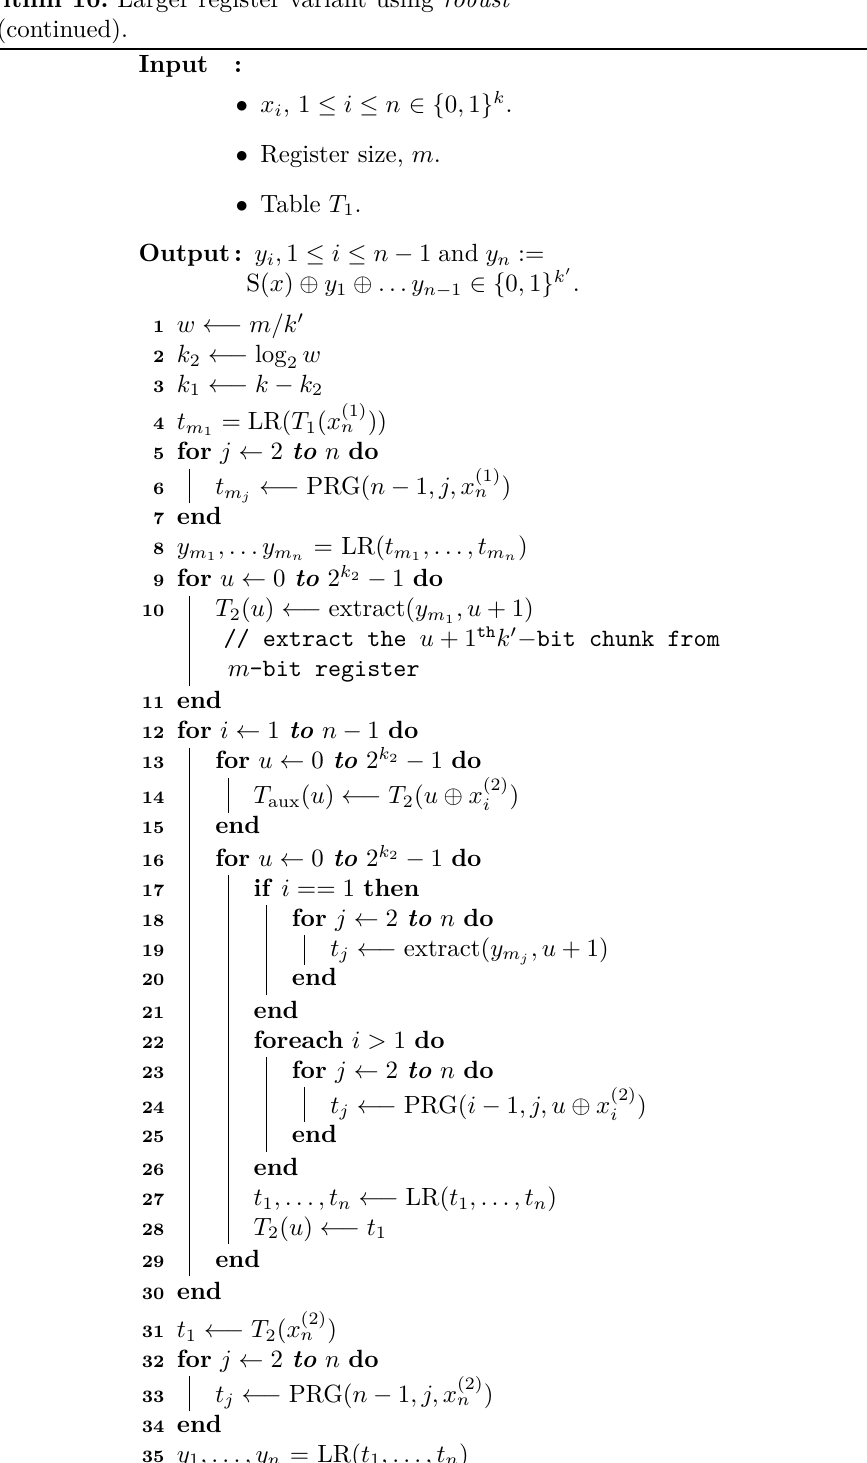
Algorithm 10: Larger register variant using robust PRG